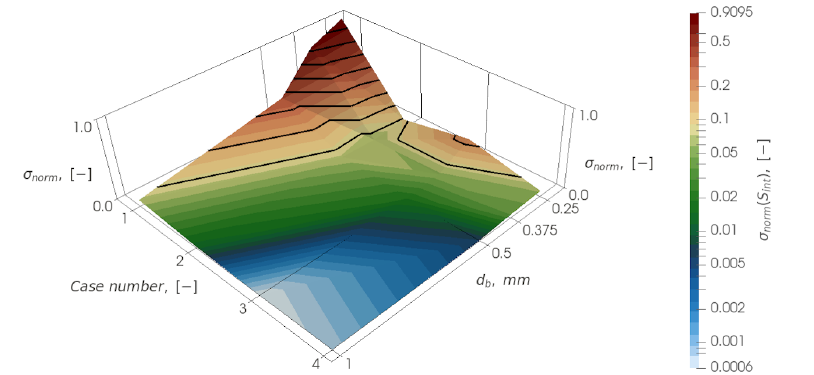
Figure 9. Distribution of a weighted variance σ norm for the interfacial area density, S int